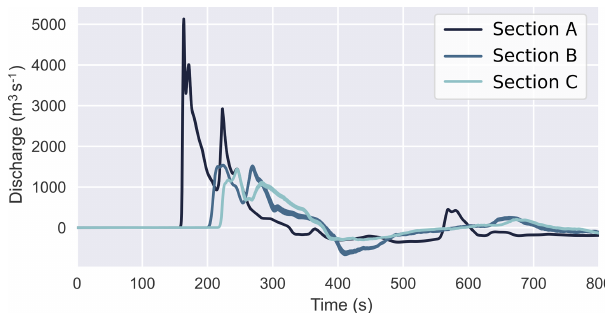
Figure 12. Time series plot of discharge for the largest, nearest source at each Waikato River inlet